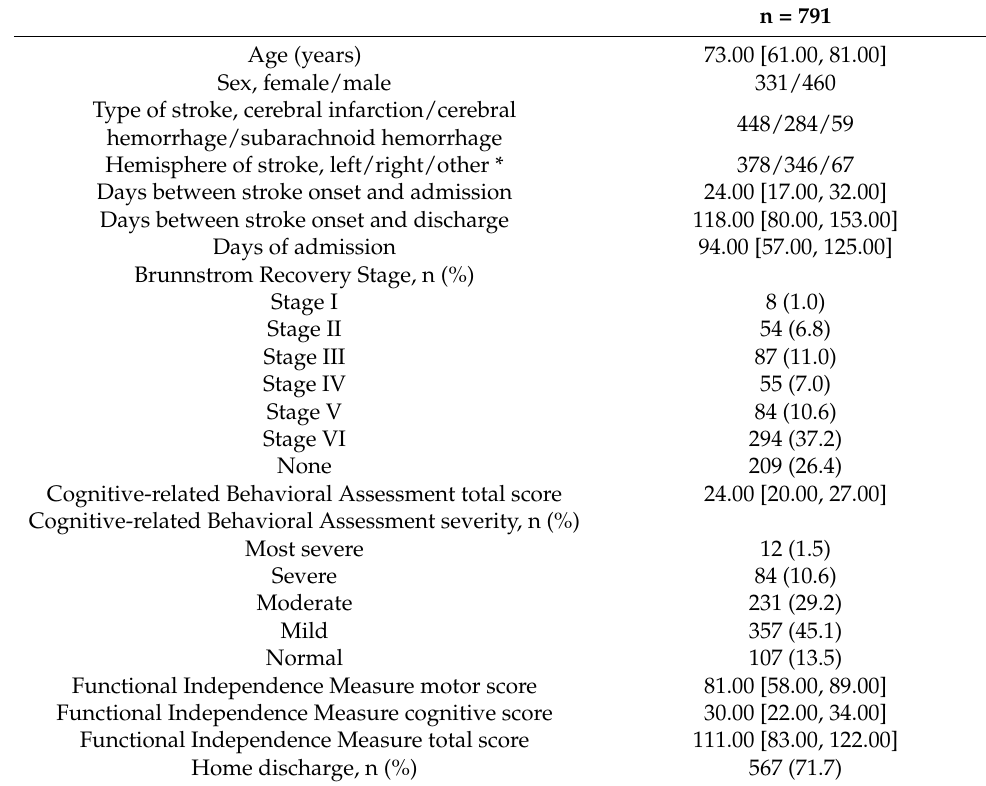
Table 1. Patient